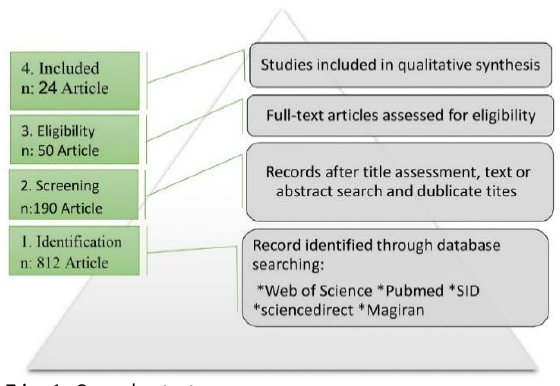
Fig. 1. Search strategy